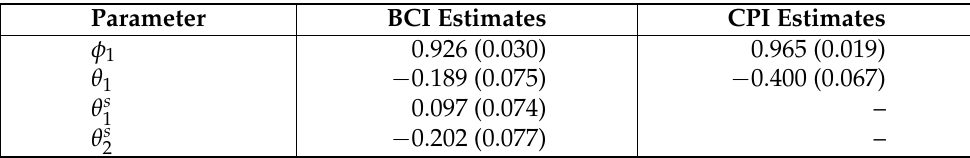
Table 2. Estimates and standard errors (in parentheses) for SARIMA and ARIMA models for BCI and CPI,